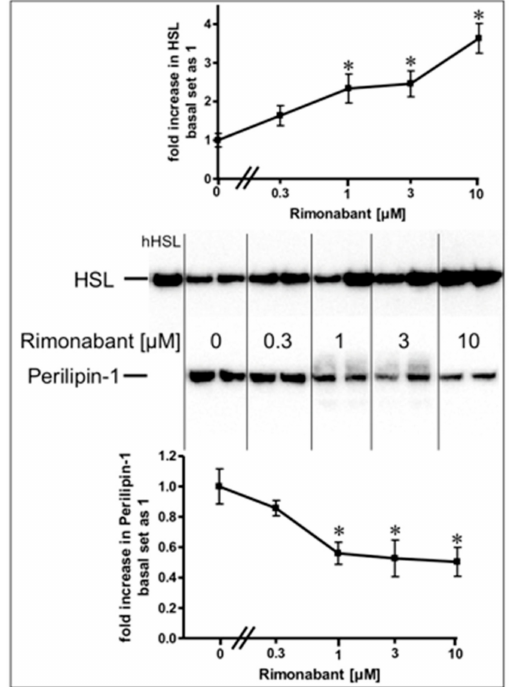
Figure 2. Stimulation of the translocation of hormone-sensitive lipase (HSL) and perilipin-1 by Rimonabant during adipocyte lipolysis. Primary rat adipocytes were incubated (20 min, 37 ◦ C) in the absence or presence of increasing concentrations of Rimonabant. Subsequently, LD were prepared from the homogenate of the washed adipocytes by centrifugation through a sucrose cushion (see Materials and Methods). The top fractions were extracted for removal of lipids. Proteins were then separated by sodium dodecylsulfate polyacrylamide gel electrophoresis (SDS-PAGE) and analyzed for HSL and perilipin-1 by immunoblotting. The images of a typical experiment with electrophoretic runs in duplicate and repeated two times are shown with similar results. hHSL, recombinant human HSL was run in parallel as marker. The quantitative evaluation of the three experiments is shown (mean ± SD). * p ≤ 0.05 vs. absence of